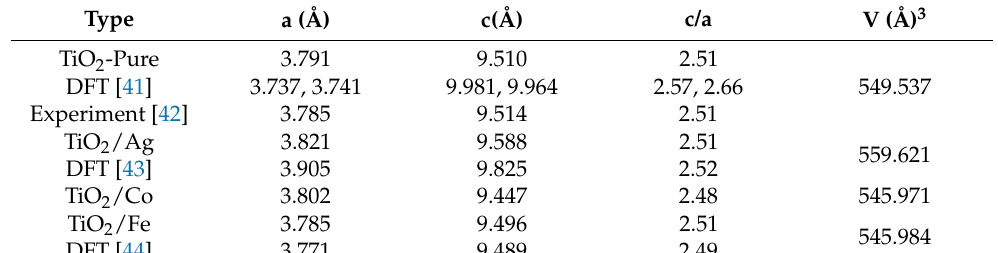
Table 1. Lattice parameters, volume, and c/a of pristine and doped TiO 2 anatase.